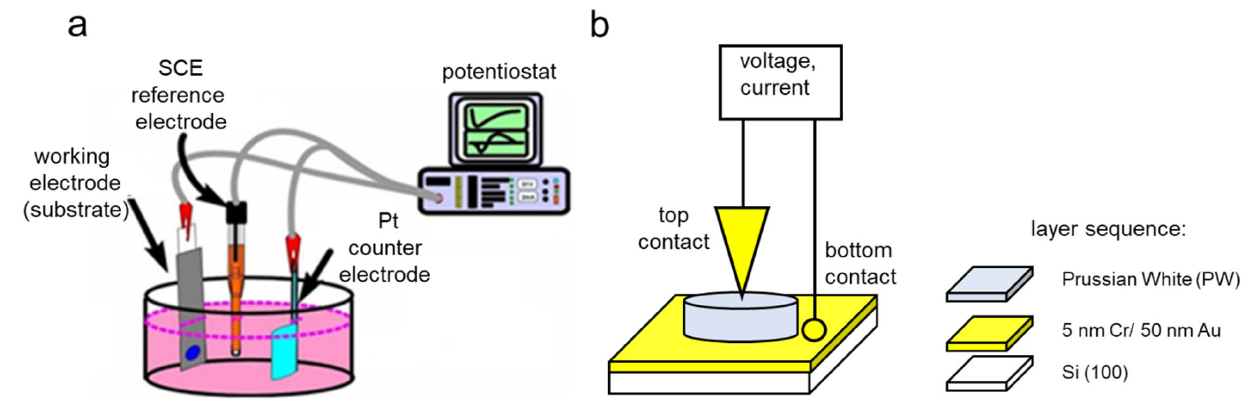
Figure 1. ( a ) Experimental setup for the electrochemical deposition of PW. ( b ) Layer sequence of the samples and applied electrode configuration for electrical measurements.